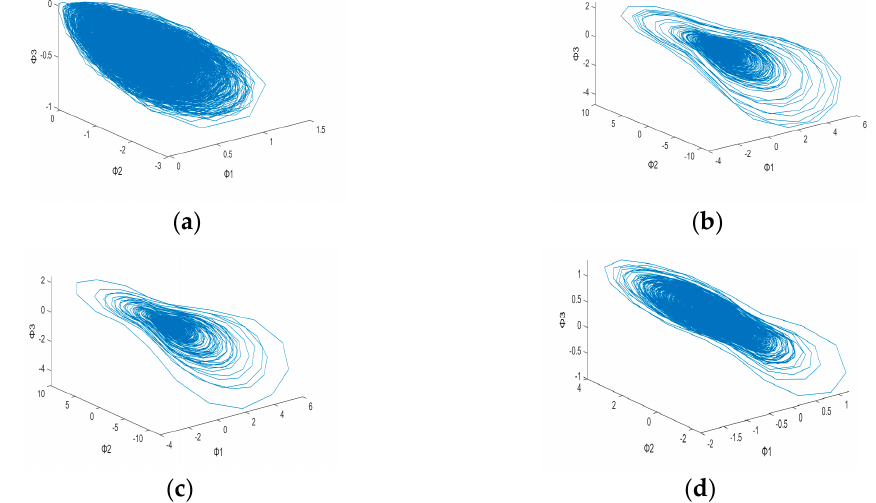
Figure 4. 3D dynamic error phase diagram of a ball bearing under testing, with α = 0.3, HP = 0, and SPOF diameter = 0.007 in. ( a ) Normal state. ( b ) Ball fault. ( c ) Inner race fault. ( d ) Outer race fault.